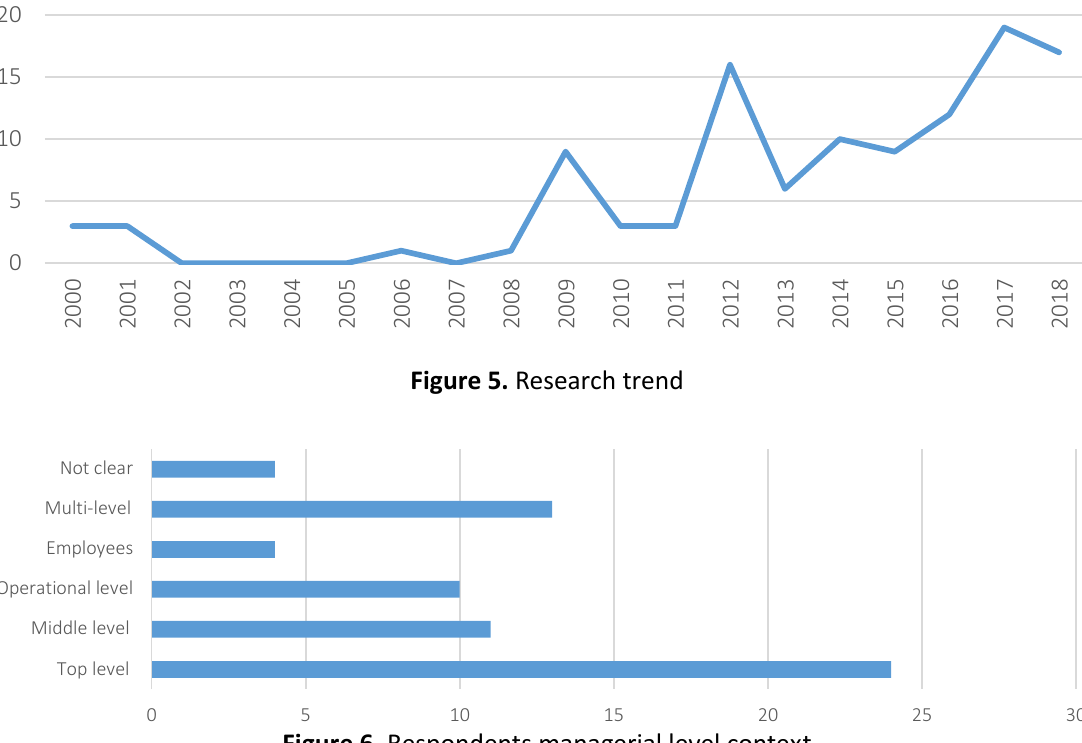
Figure 5. Research trend